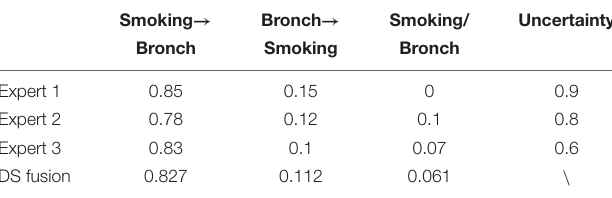
TABLE 3 | Expert knowledge fusion of nodes “Smoking and